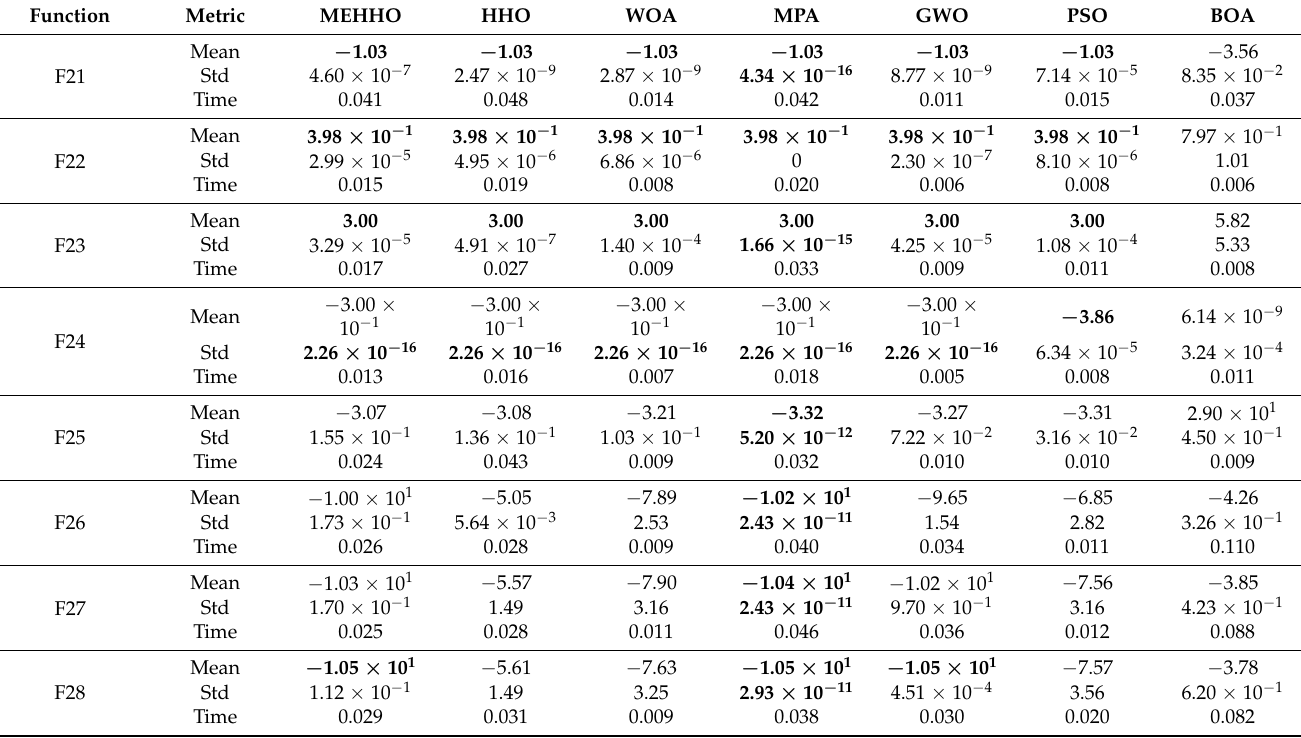
Table 6. Comparison of fixed-dimension multimodal functions test